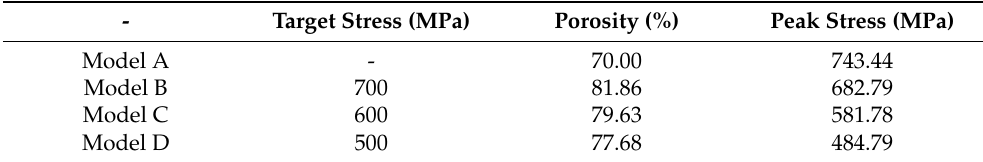
Figure 5. Geometric features and mechanical properties of the porous scaffolds. ( A ) Strut diameter distribution of the porous scaffolds, ranging from 0.3 mm to 0.7 mm (0.01 mm interval). ( B ) Stress distribution of porous scaffolds. Table 1. The performance parameters for porous scaffolds, covering porosity and peak stress.